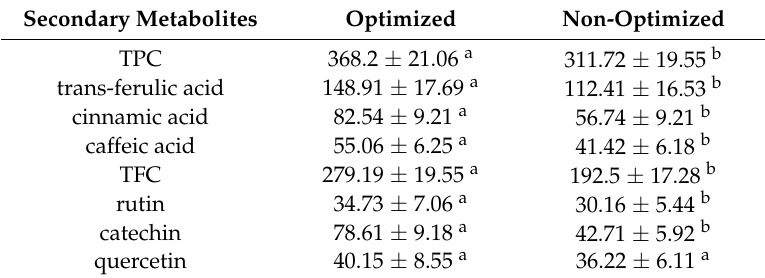
Table 4. Total phenolic content (TPC), total flavonoid content (TFC), and individual phenolics and flavonoids from optimized and non-optimized extracts of Garcinia mangostana